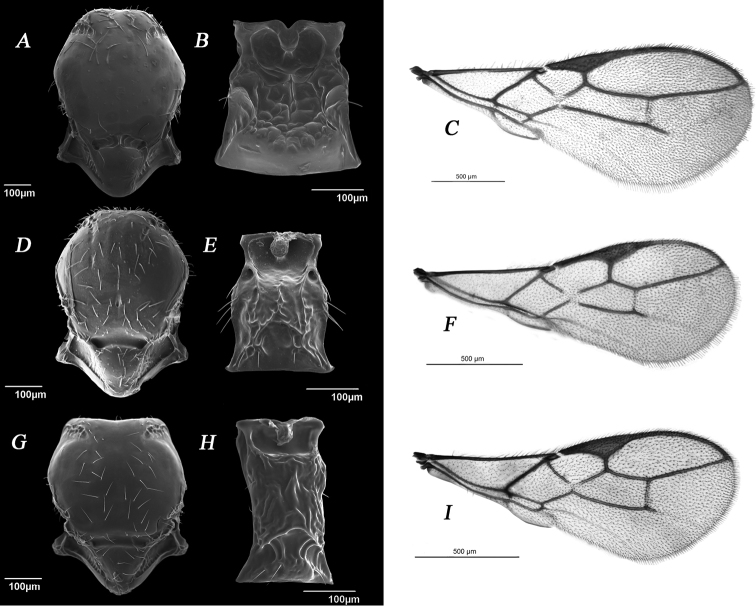
Representative species of the subgenera Breviephedrus (E.
brevis), Fovephedrus (E.
persicae), and Ephedrus (E.
plagiator). A–CBreviephedrusA mesoscutum dorsal view B petiole, dorsal view C forewing D–FFovephedrusD mesoscutum dorsal view E petiole, dorsal view F forewing G–IEphedrusG mesoscutum, dorsal view H petiole, dorsal view I forewing.